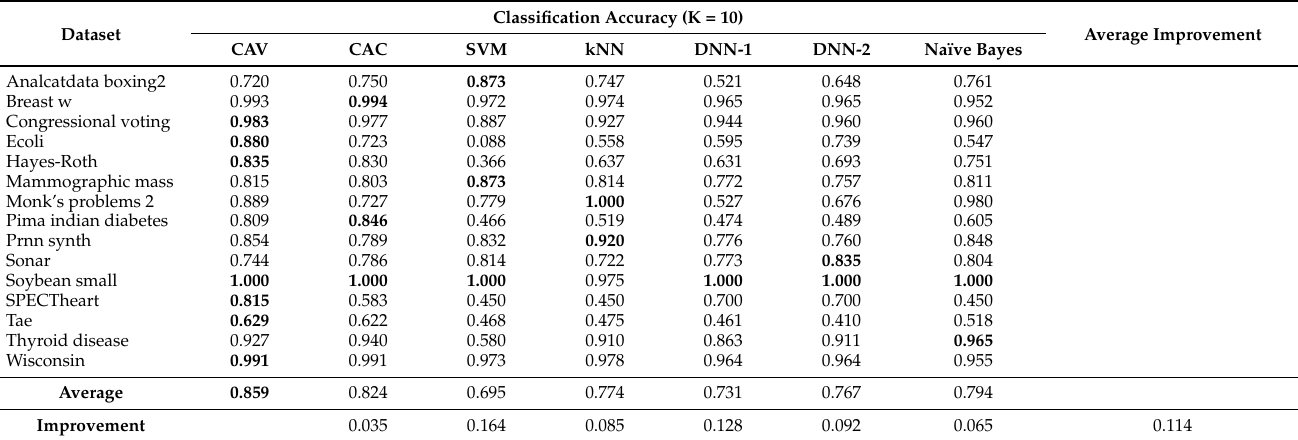
Table 5. The precision of the proposed CAV compared with CAC, SVM, k-NN, DNN-1, DNN-2 and naïve Bayes (the bold number indicates the maximum value).